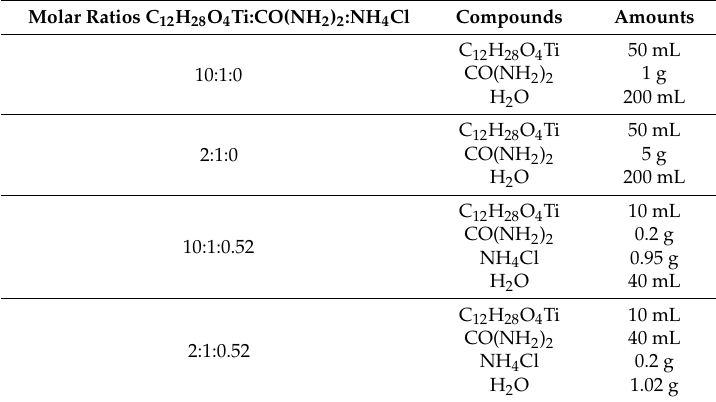
Table 4. Reagents for Synthesis